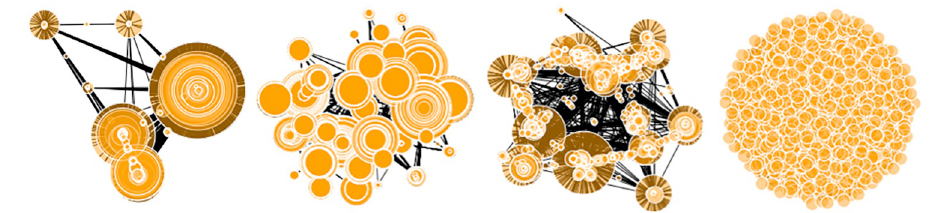
Fig 6. From left to right: The T lymphocyte tissue-specific network, the C. elegans network, a random network from the proposed generator, and a random network from the BA model.